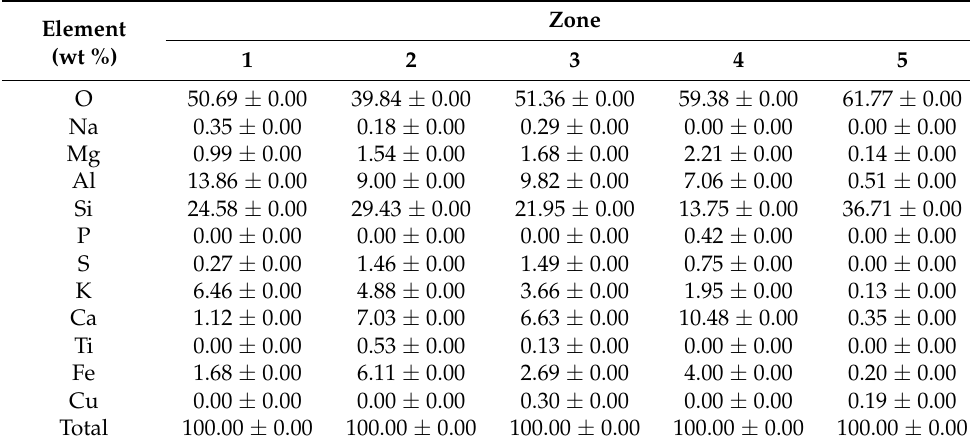
Table 4. EDS microanalysis (wt %) of the areas marked in Figure 5a (CHM powder). Element